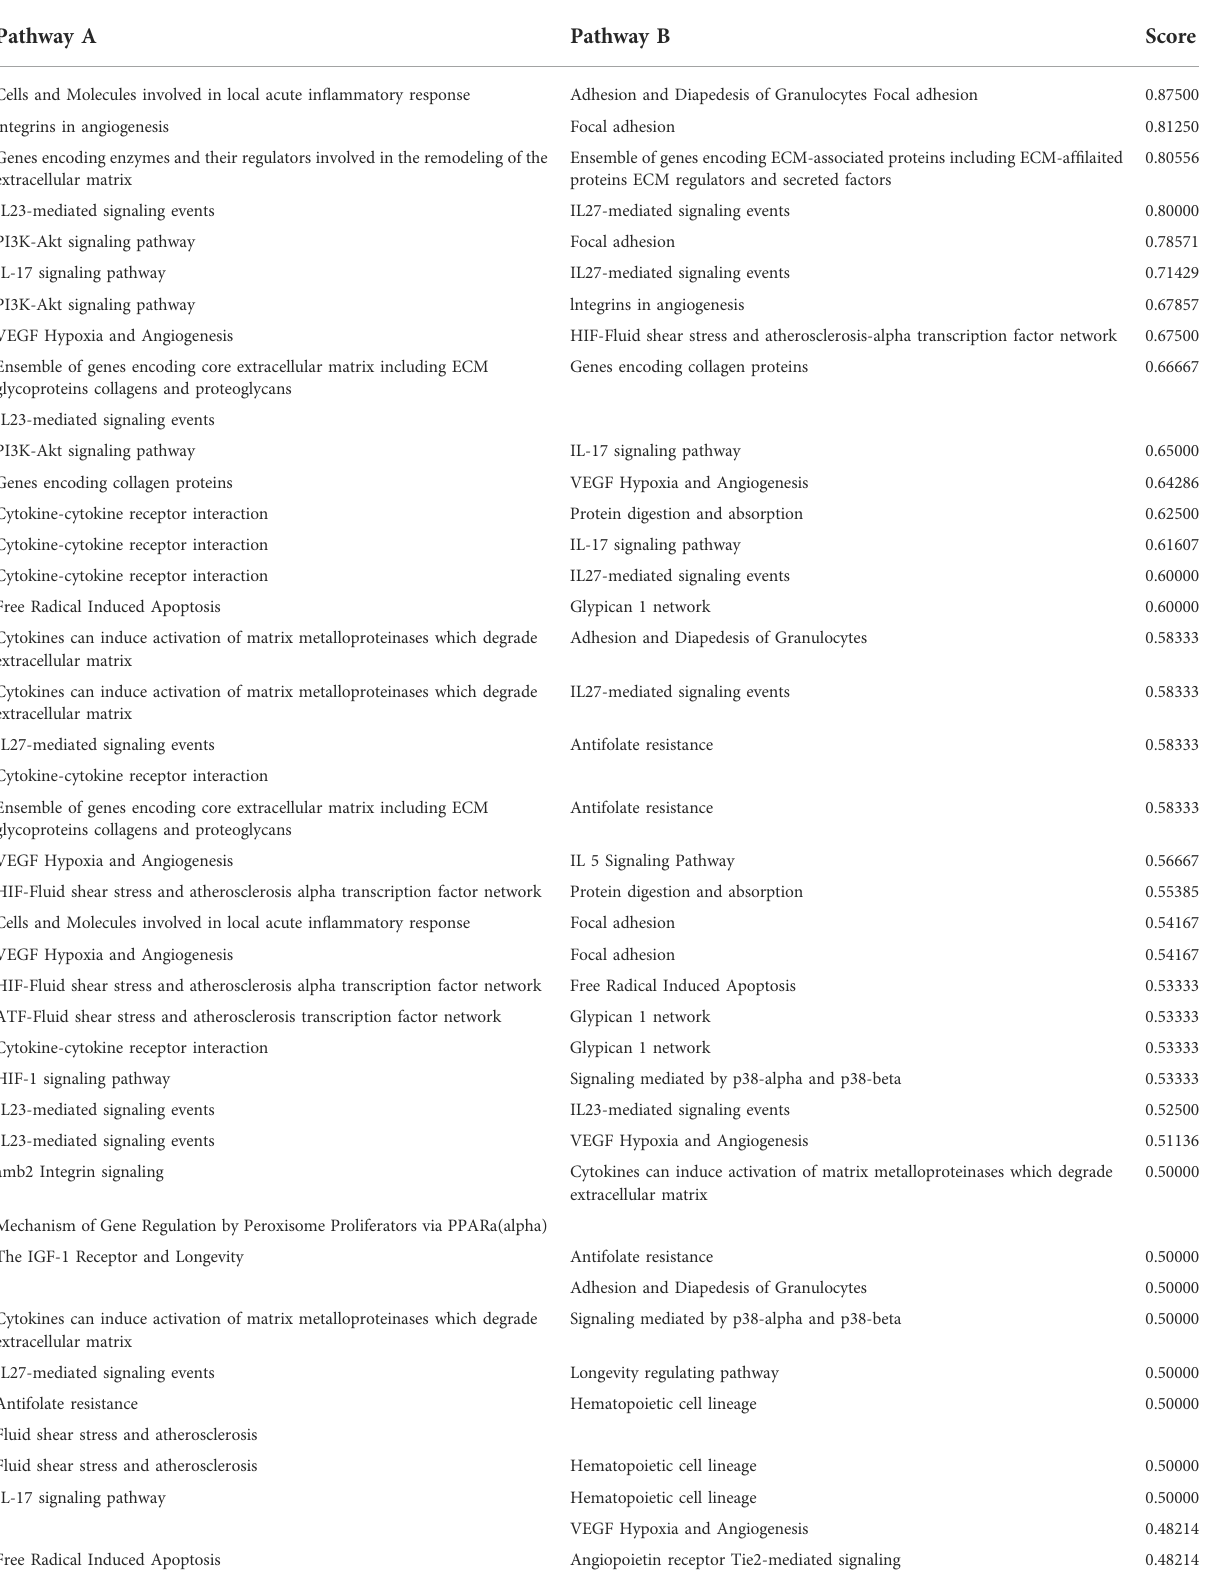
TABLE 4 Pathway crosstalk